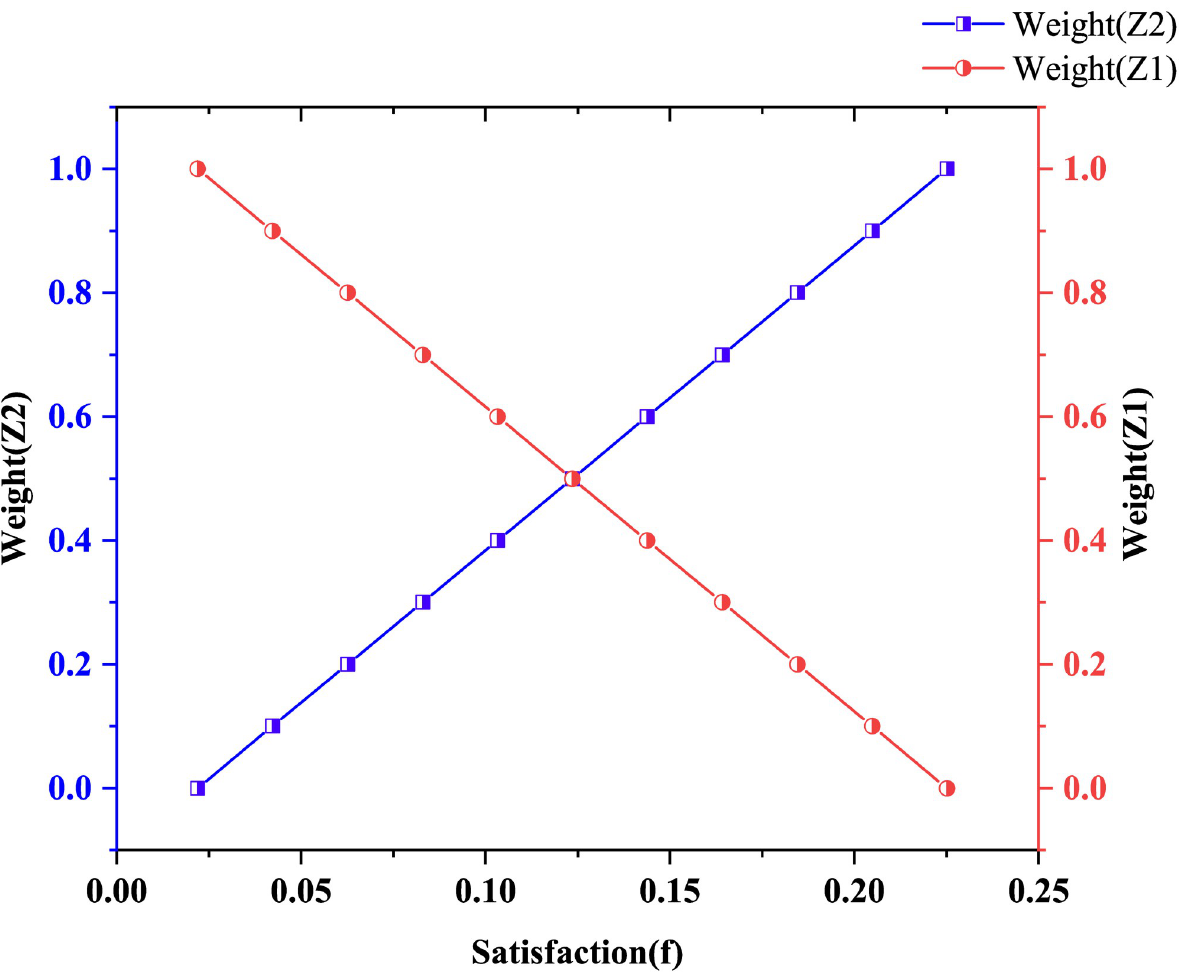
Fig 7. The influence of supply and demand index weight on the total